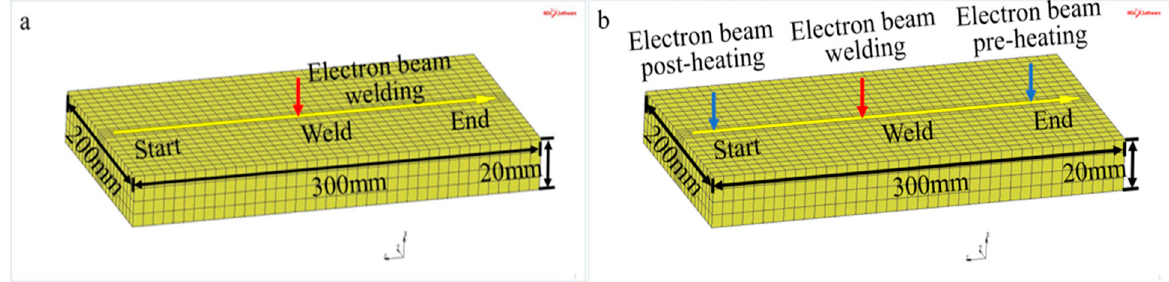
Figure 6. Finite element model. ( a ) finite element model of one time welding, ( b ) finite element model of pre-heating, welding and post heating.